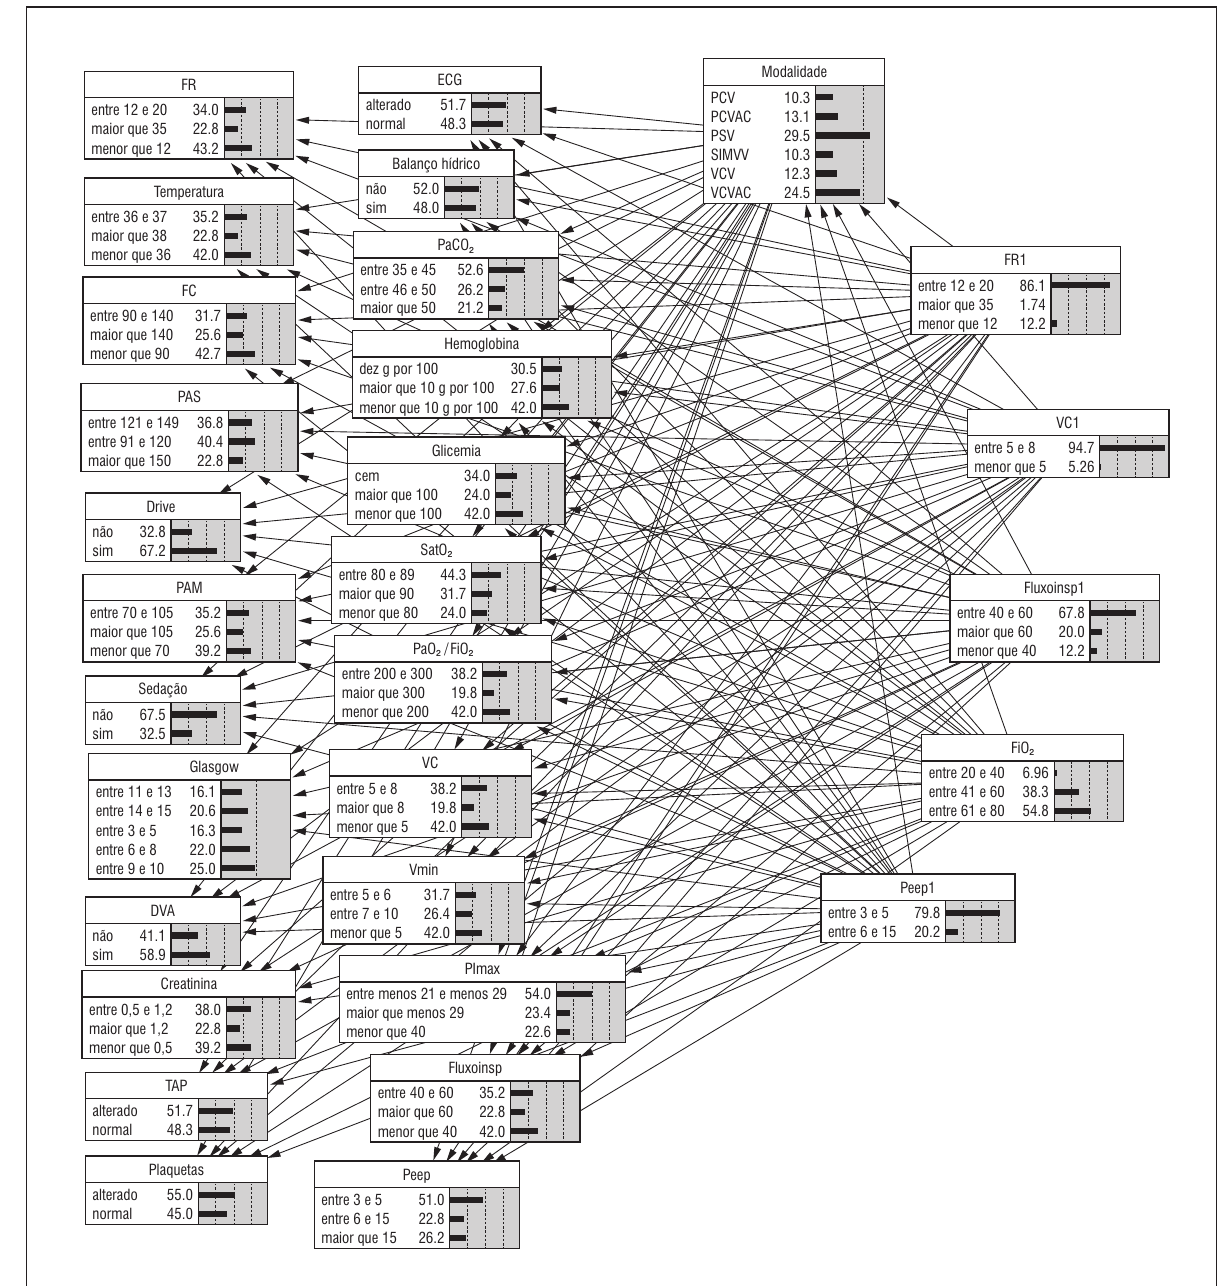
Figura 1 - Representação quantitativa da rede bayesiana Fonte: Dados da pesquisa.